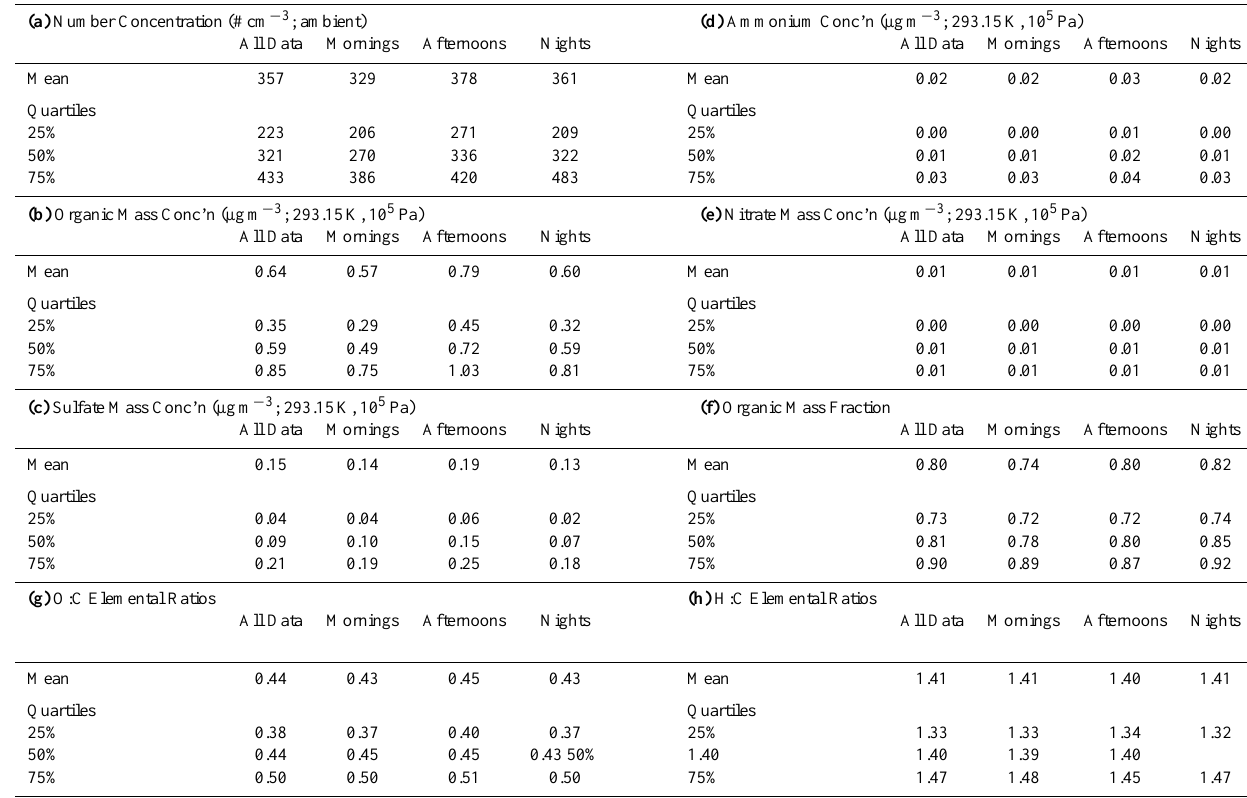
Table 2. Mean and quartiles of (a) CPC number concentration ( ± 10%), (b) AMS-measured organic mass concentration ( ± 30%), (c) AMS- measured sulfate mass concentration ( ± 30%), (d) AMS-measured ammonium mass concentration ( ± 30%), (e) AMS-measured nitrate mass concentration ( ± 30%), (f) organic mass fraction calculated as b divided by the sum of b to e , (g) AMS-measured oxygen-to-carbon (O:C) elemental ratios of the organic particle-phase material, and (h) AMS-measured hydrogen-to-carbon (O:C) elemental ratios of the organic particle-phase material. Data are screened to remove time periods affected by local pollution (“all data” column). Data are also shown segregated into morning, afternoon, and